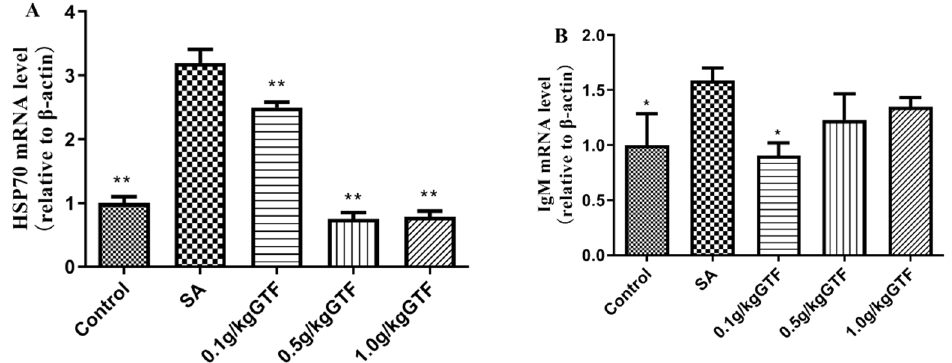
Figure 8. Effects of GTF on the mRNA levels of HSP70 ( A ) and IgM ( B ) in the liver of tilapia. Values are expressed as mean ± SEM ( n = 10). * p < 0.05 and ** p < 0.01 compared with streptococcal injection group.